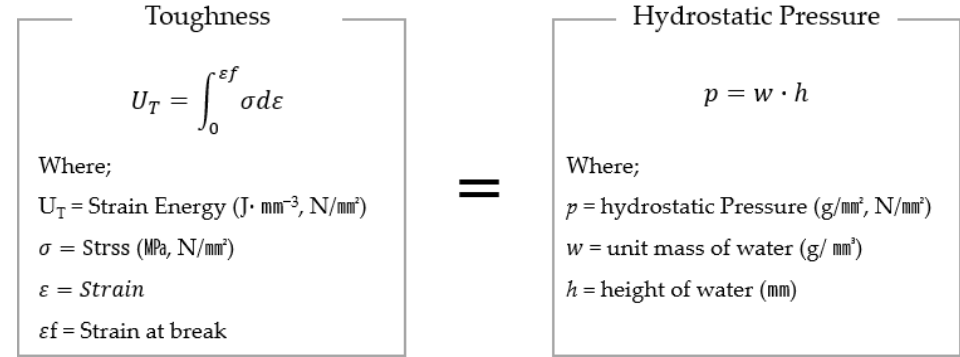
Figure 2. Equal equation of toughness and hydrostatic pressure.